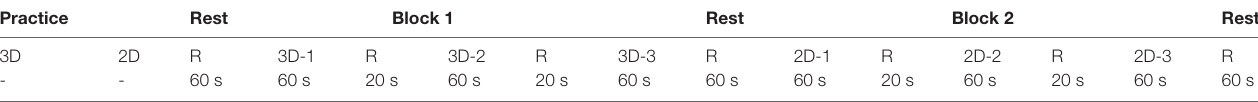
TABLE 1 | Protocol timeline for 3D/B1 participants.